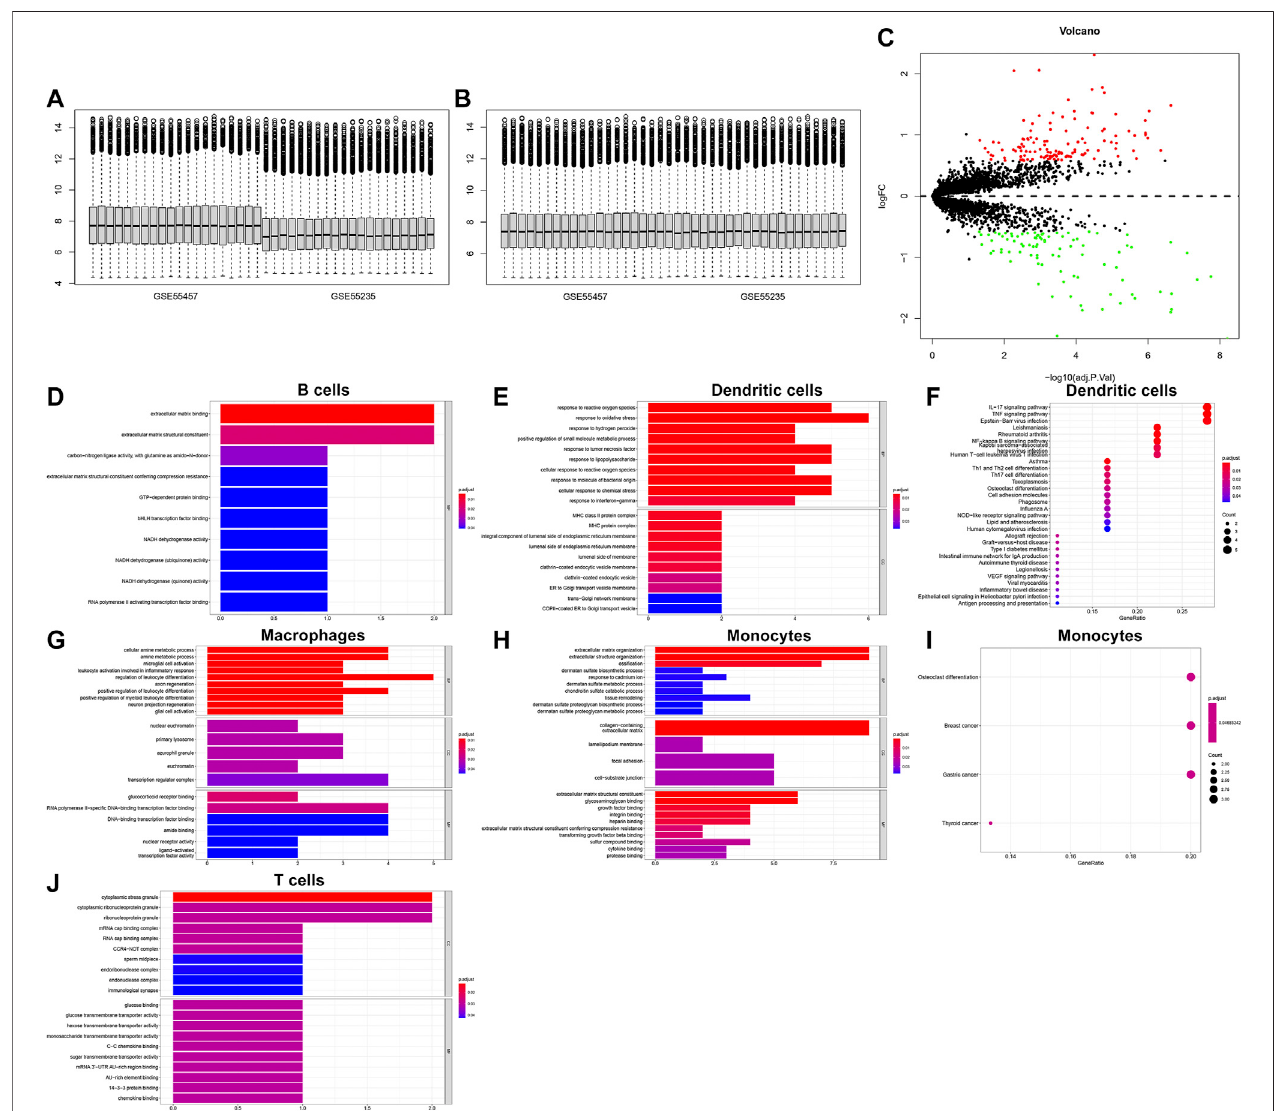
FIGURE10| Biologicalfunctionsofdifferentiallyexpressedmarkergenesin fi veimmunecells. (A,B) BeforeandafterbatcheffectsoftheintegratedGSE55235and GSE55457 datasets. (C) Volcano plots of differentially expressed genes between OA and normal synovial tissues. (D – J) Functional annotation analysis of differentially expressed marker genes in (D) B cells, (E,F) dendritic cells, (G) macrophages, (H,I) monocytes, and (J) T